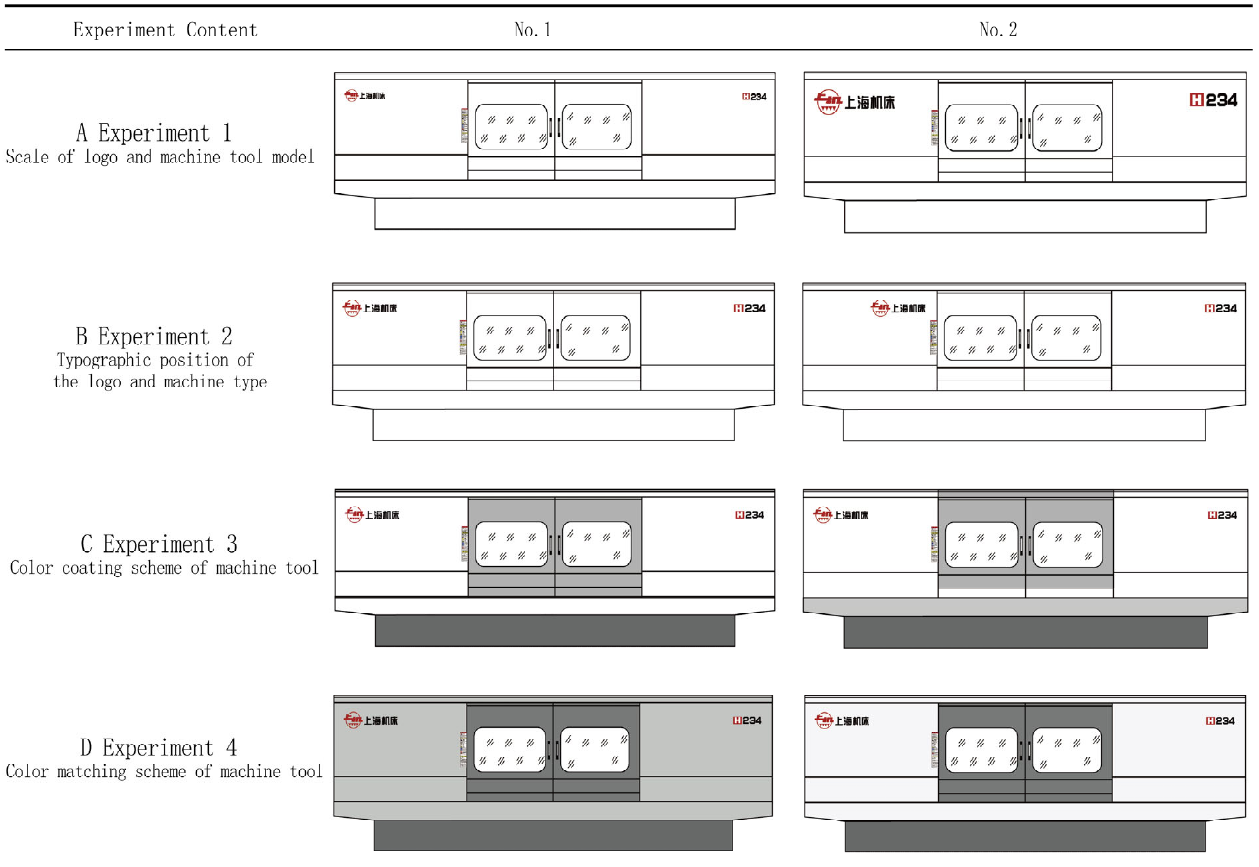
Figure 1. Different types of machine tools from Shanghai Machinery Factory.